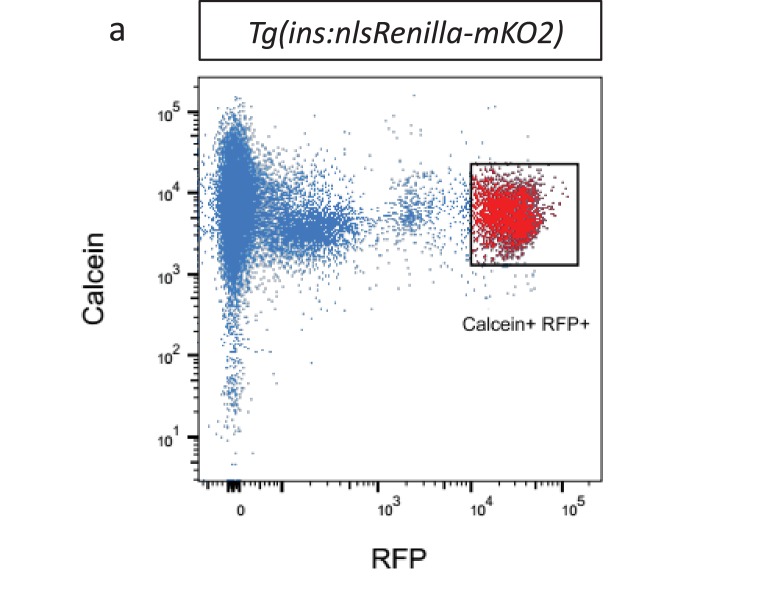
Fluorescent activated cell sorting of beta-cells.(a) Fluorescent activated cell sorting (FACS) of RFP-positive and calcein-positive beta-cells from Tg(ins:nlsRenilla-mKO2) animals.